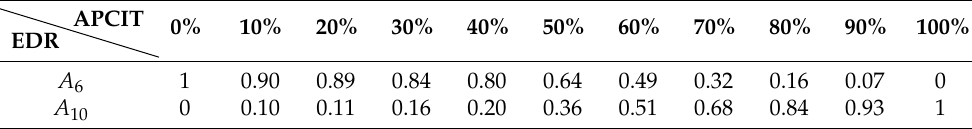
Table 1. EDR results of transducer at different moving distances.